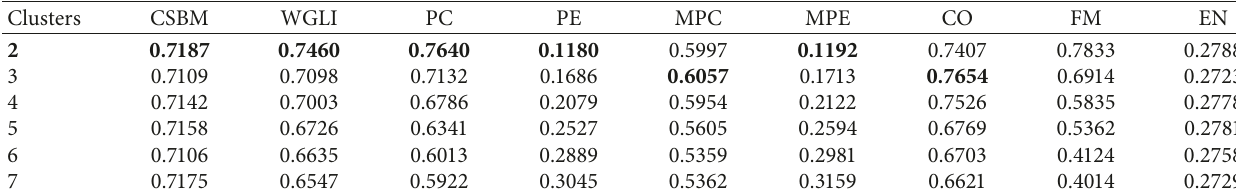
Table 5: Values of each index on the wpbc dataset.